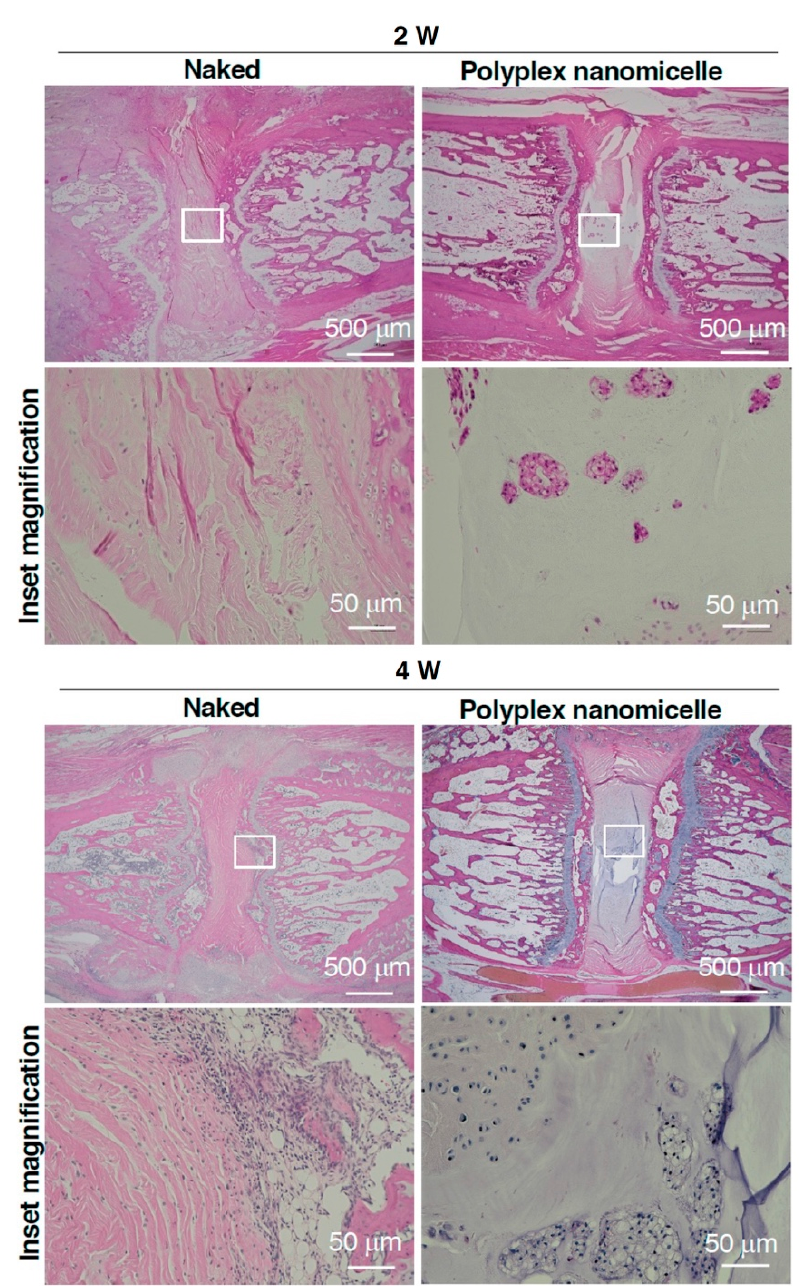
Figure 6. H&E staining examining the fibrous tissue and jelly-like material in the disc. Representative images from the post-punctured animal. Runx1 mRNA was injected in naked form compared with that loaded in polyplex nanomicelle form. The punctured disc was collected at 2- and 4-weeks post-injection and subjected to H&E staining. The boxed area was magnified to observe the detailed fibrous tissue infiltration or jelly-like material used to represent the hydration content. n = 4.